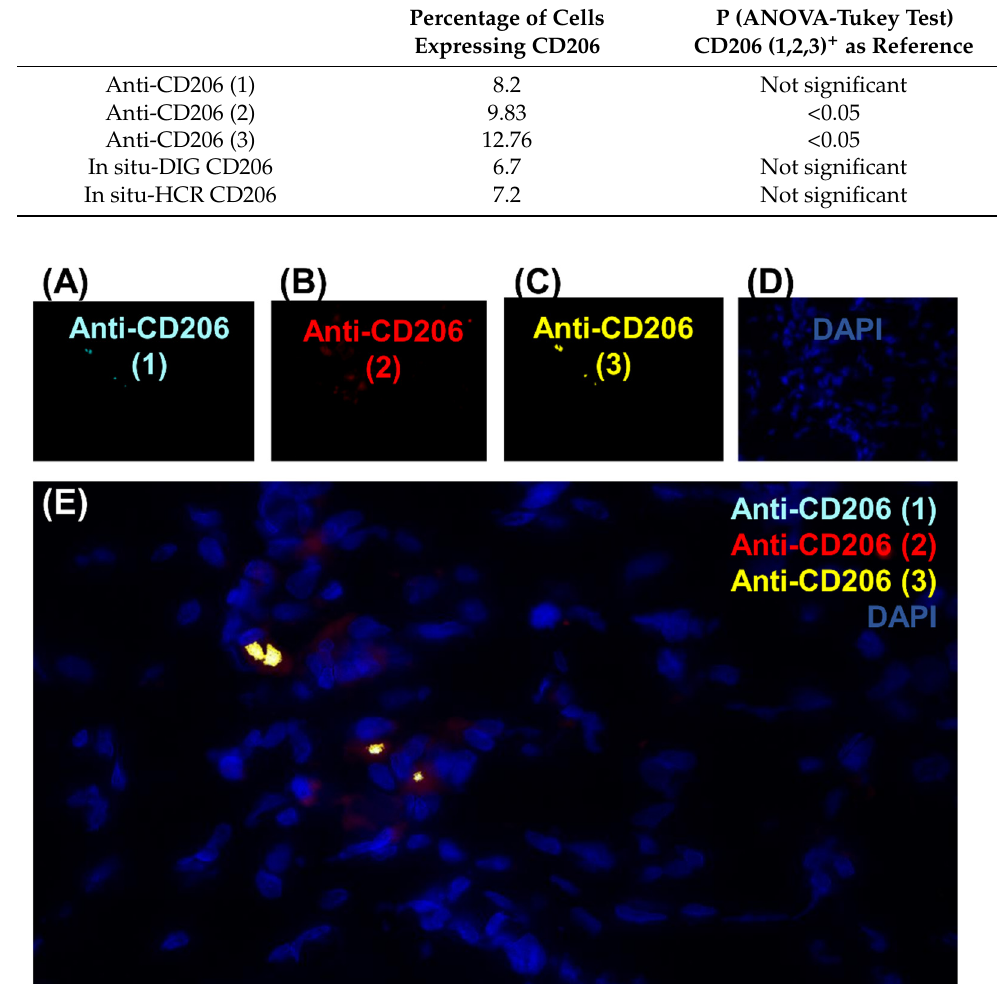
Table 1. Quantitative analysis of CD206-expressing cells by immunofluorescence method and in situ hybridization. Random examination of three sets of 1000 cells per condition.